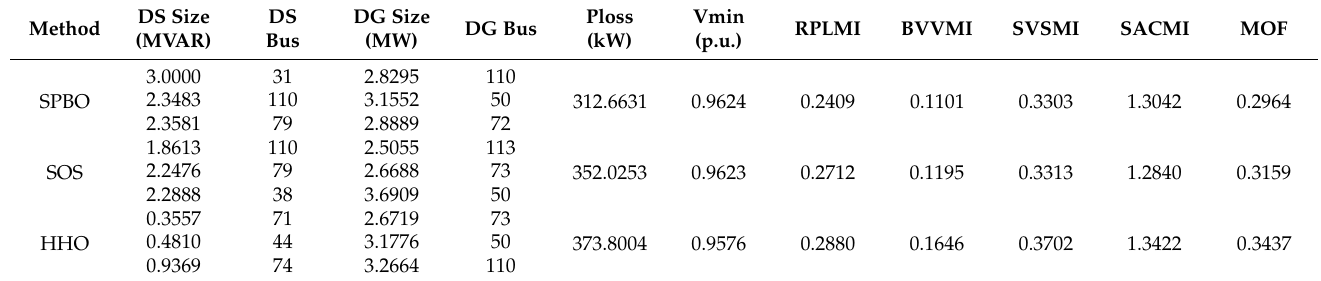
Table 16. Comparison of results for simultaneous DS and 1 PV-DG and 2 GT-DG allocation (case-8) for 118-bus test